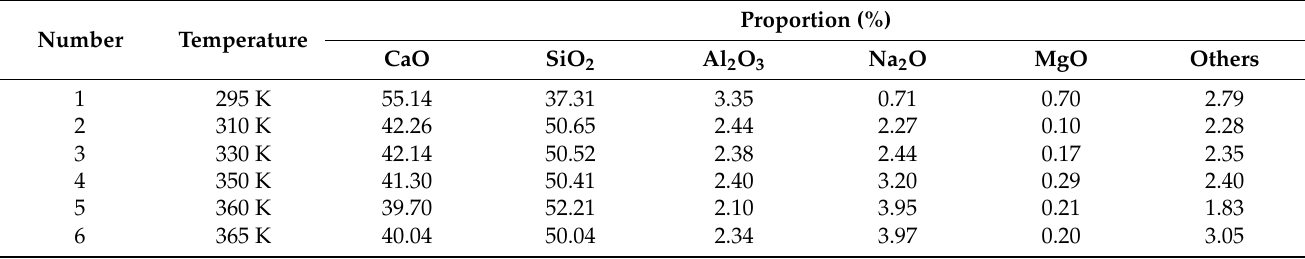
Table 3. The composition of microporous calcium silicate was synthesized at different